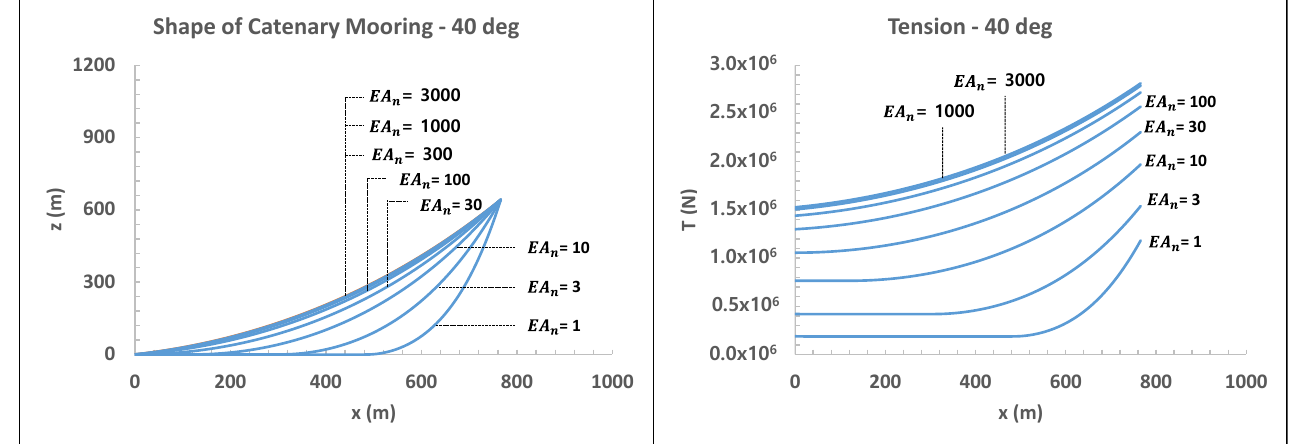
Figure 10. Results for static analysis of mooring line considering seabed condition when q is 40°.